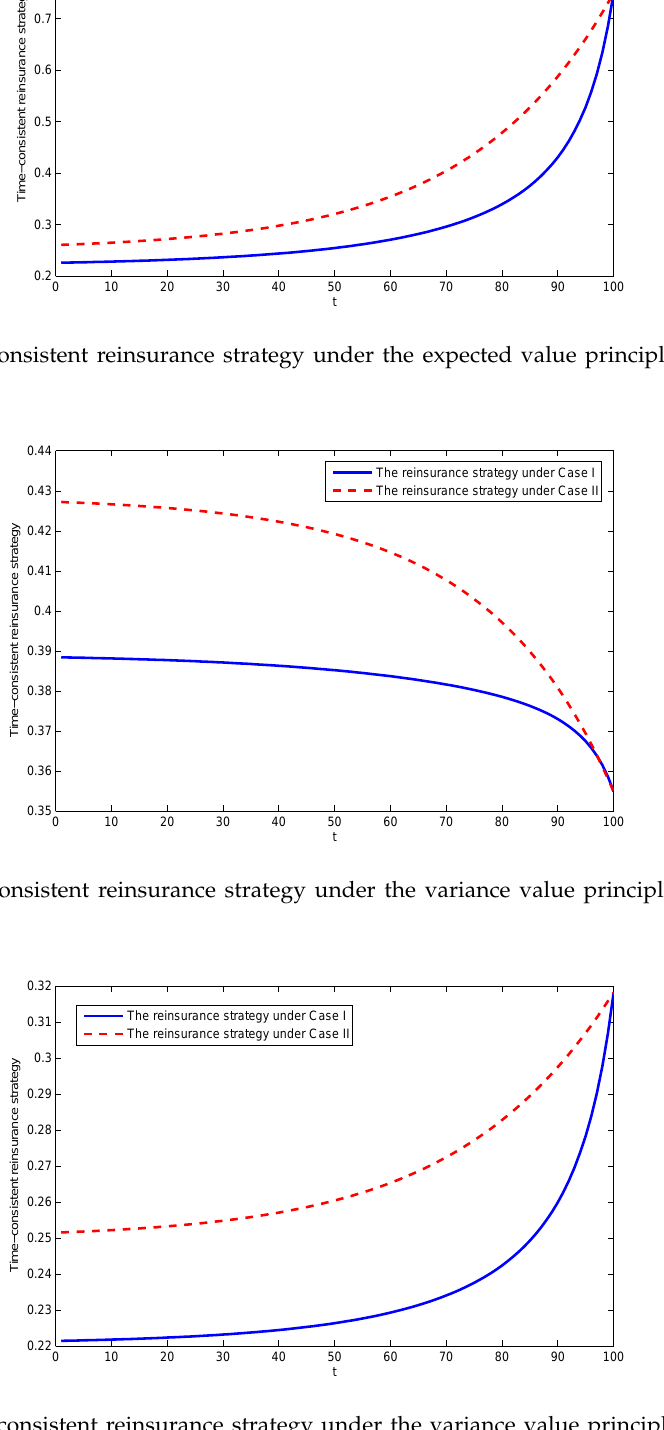
Figure 10. Time-consistent reinsurance strategy under the variance value principle ( α = 0.6 and T =